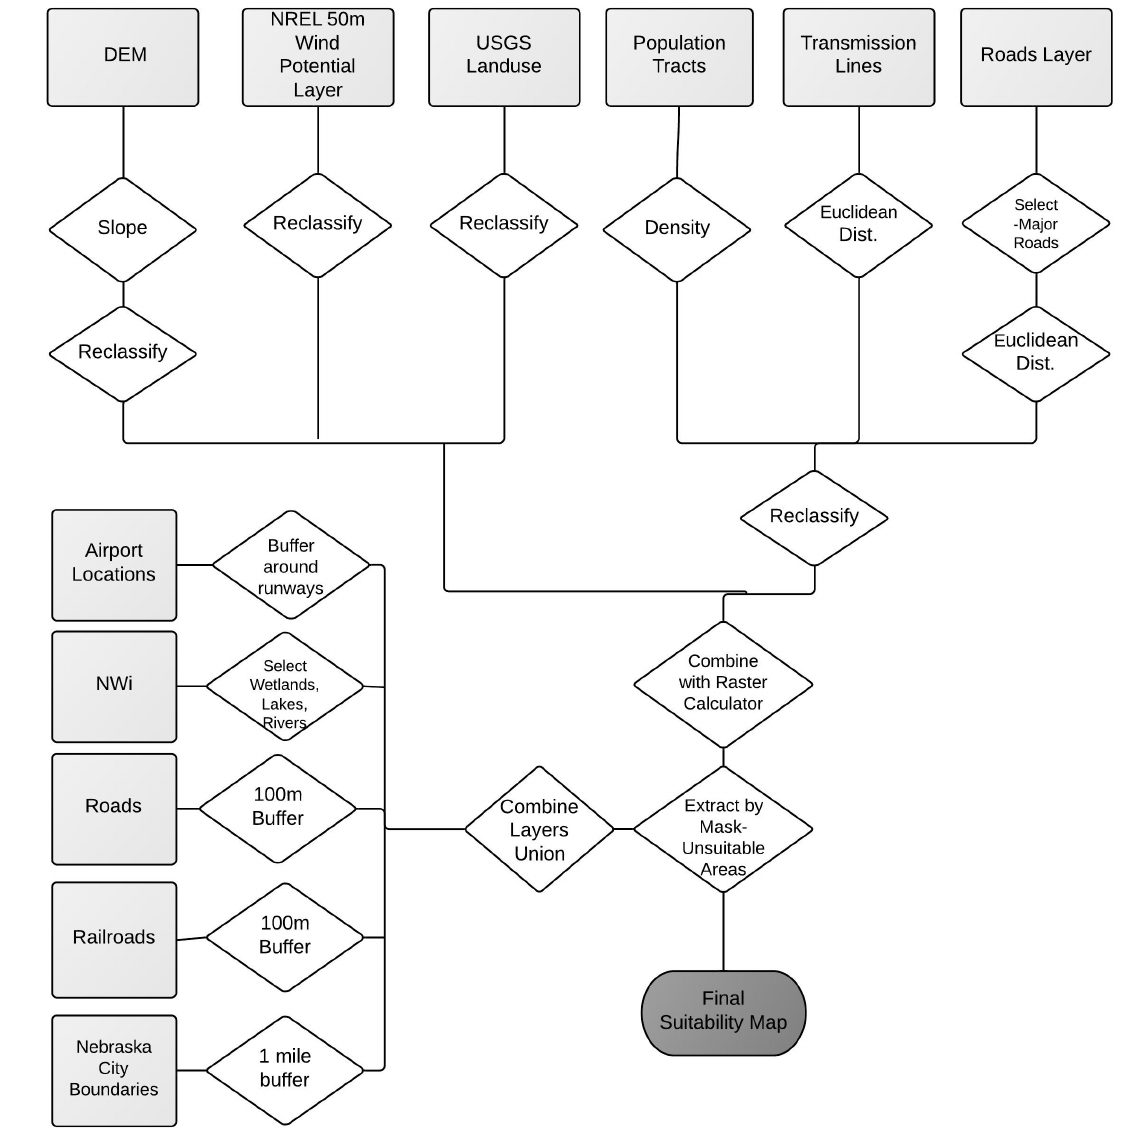
Figure 4. Flowchart for modeling suitability of wind farm